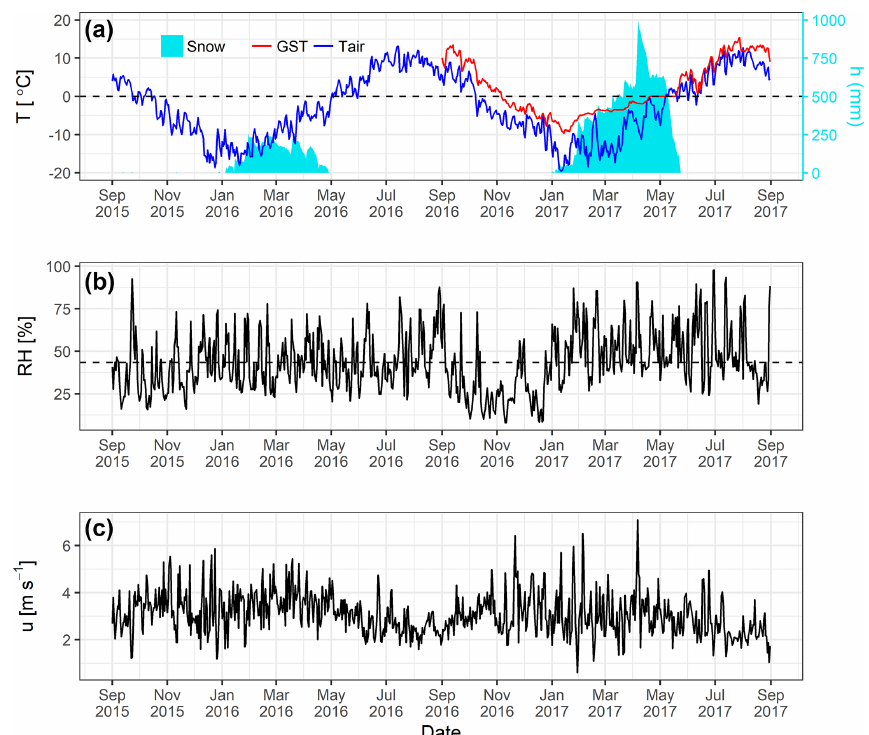
Figure 5. Daily mean values of observed (a) air temperature (blue) and 1-year GST (red) ( T ; ◦ C) with snow depth (mm) on the secondary axis, (b) relative humidity (RH; %) with a dashed line as mean RH, and (c) wind speed ( u ; ms − 1 ) at South Pullu (4727ma.s.l.) in the